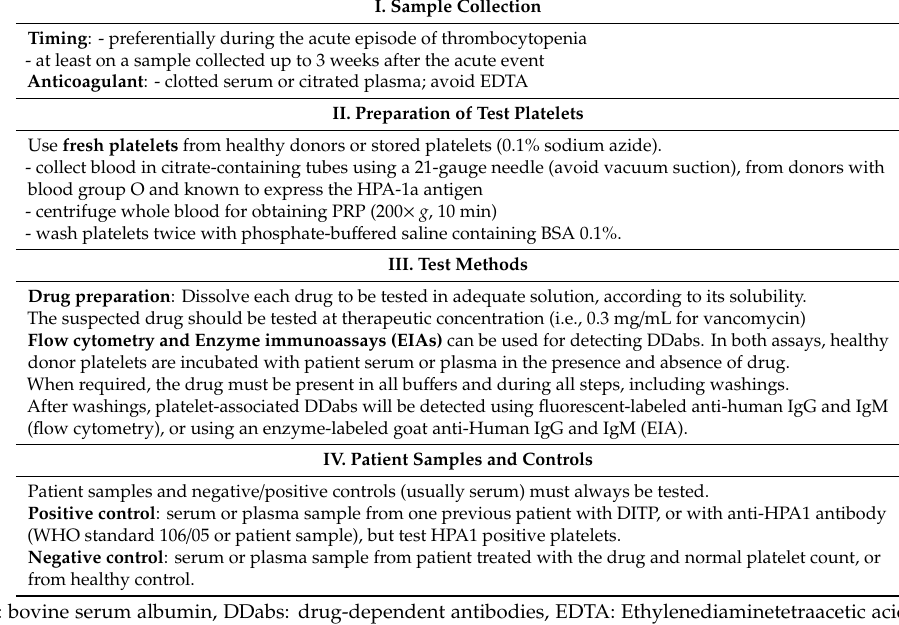
Table 3. Laboratory testing for DITP: summary of recommendations from the SSC of the ISTH